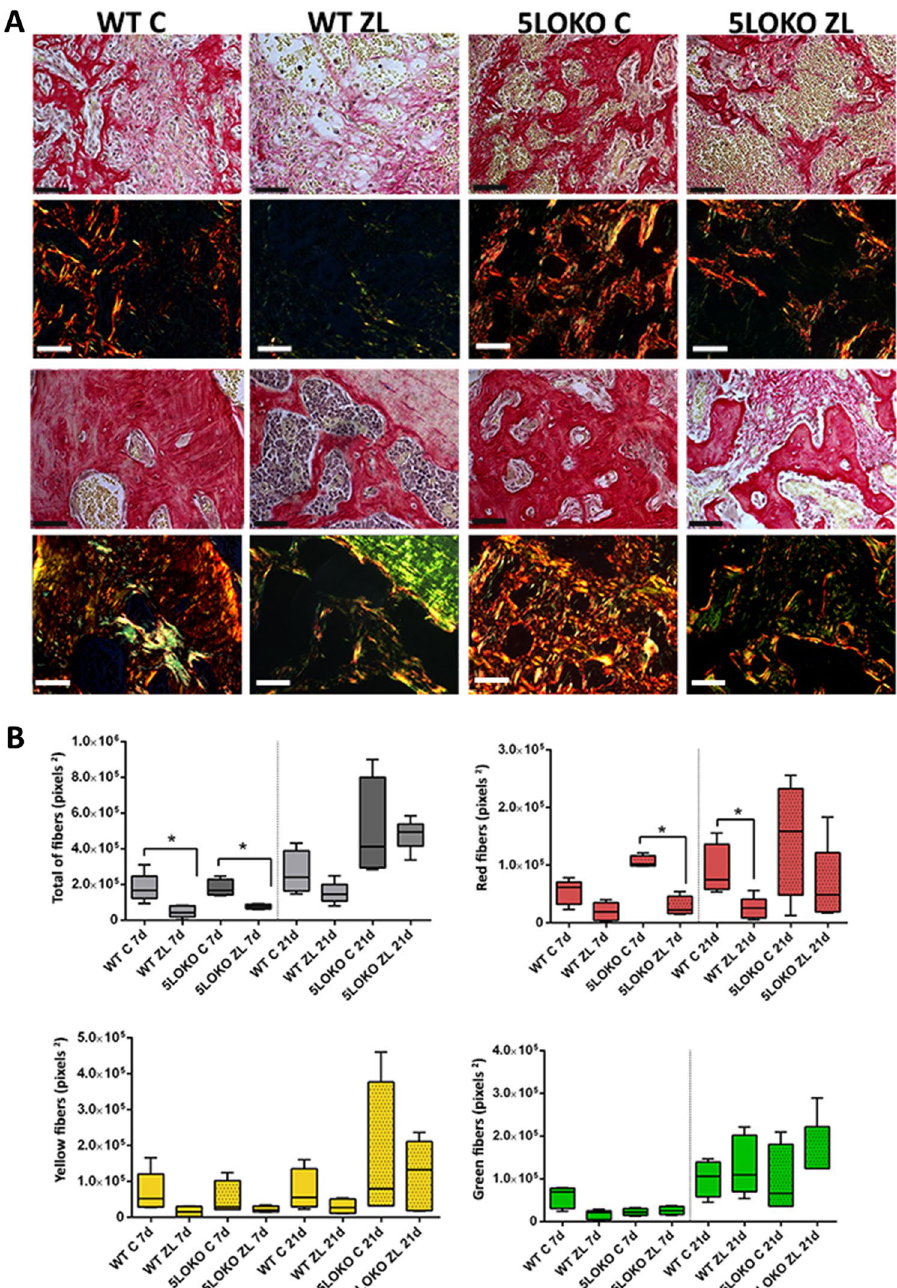
Figure 4. Birefringence analysis of collagen fibers in alveolar sockets post tooth extraction from WT vs. 5LOKO mice treated or not with ZL. Aged 129 Sv WT and 5LOKO female mice received IP injections of 0.9% saline solution ( C ) or 250 μg/Kg (ZL groups) once a week, and upper right incisor were extracted at 4 weeks of each treatment. Mice were euthanized for maxillary bones removal after 7 days and 21 days post tooth extraction. ( A ) Representative transversal sections alveolar socket upon polarized and conventional light. Polarized light shows green birefringence color for thinner collagen fibers; yellow and red colors at birefringence analysis indicate thick collagen fibers. Original magnification was 40x, Scale bar: 100 µm. ( B ) Total area (pixels 2 ) of collagen and area for each birefringence color (pixels 2 ) (green, yellow and red). RGB values for green spectra (R:114–255, G:78–255, B:10–255), yellow (R:196–255,G:32–255,B:10–255) and red (R:162–255,G:0– 175,B:0–255). Quantitative results are presented with Box and whiskers (Min to Max). Symbol * indicates a statistically significant differences between different treatments and/or genotypes (p <